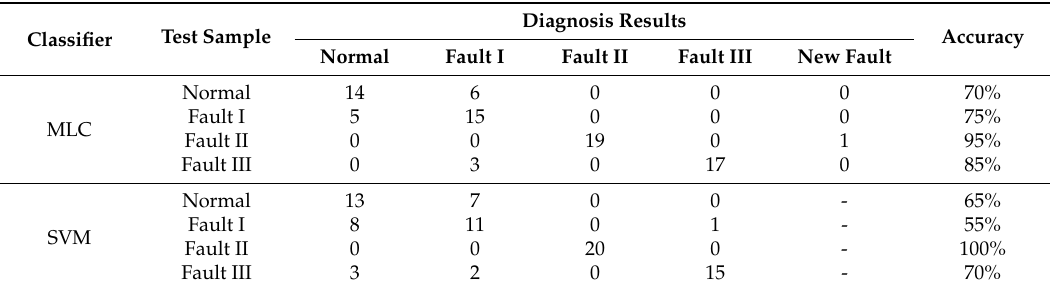
Table 3. Diagnosis results using MLC and SVM with the WSV